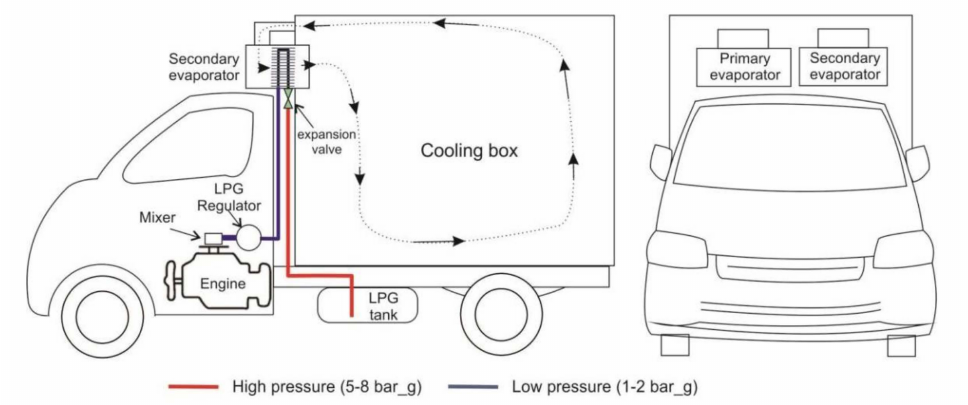
Figure 7. Hybrid cooling box vehicle for transporting fresh food products. Reprinted from ref.